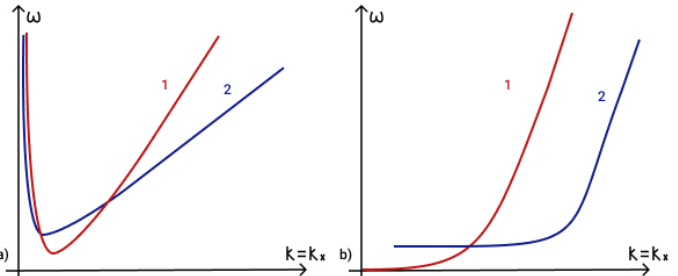
Figure 25. Phase matching conditions for ( a ) three magneto-Rossby waves in vertical magnetic field: 1— ω = ω mRv ( k x ) , 2— ω = ω mRv ( k x − k x horizontal magnetic field: 1— ω = ω mRh ( k x ) , 2— ω = ω mRh ( k x − k x